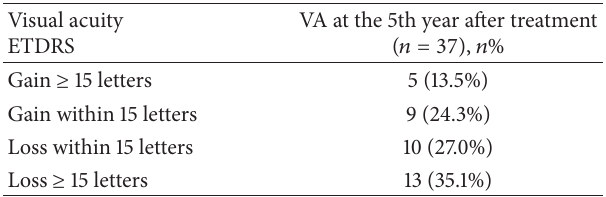
Table 1: Visual acuity gain or loss at the 5th year after